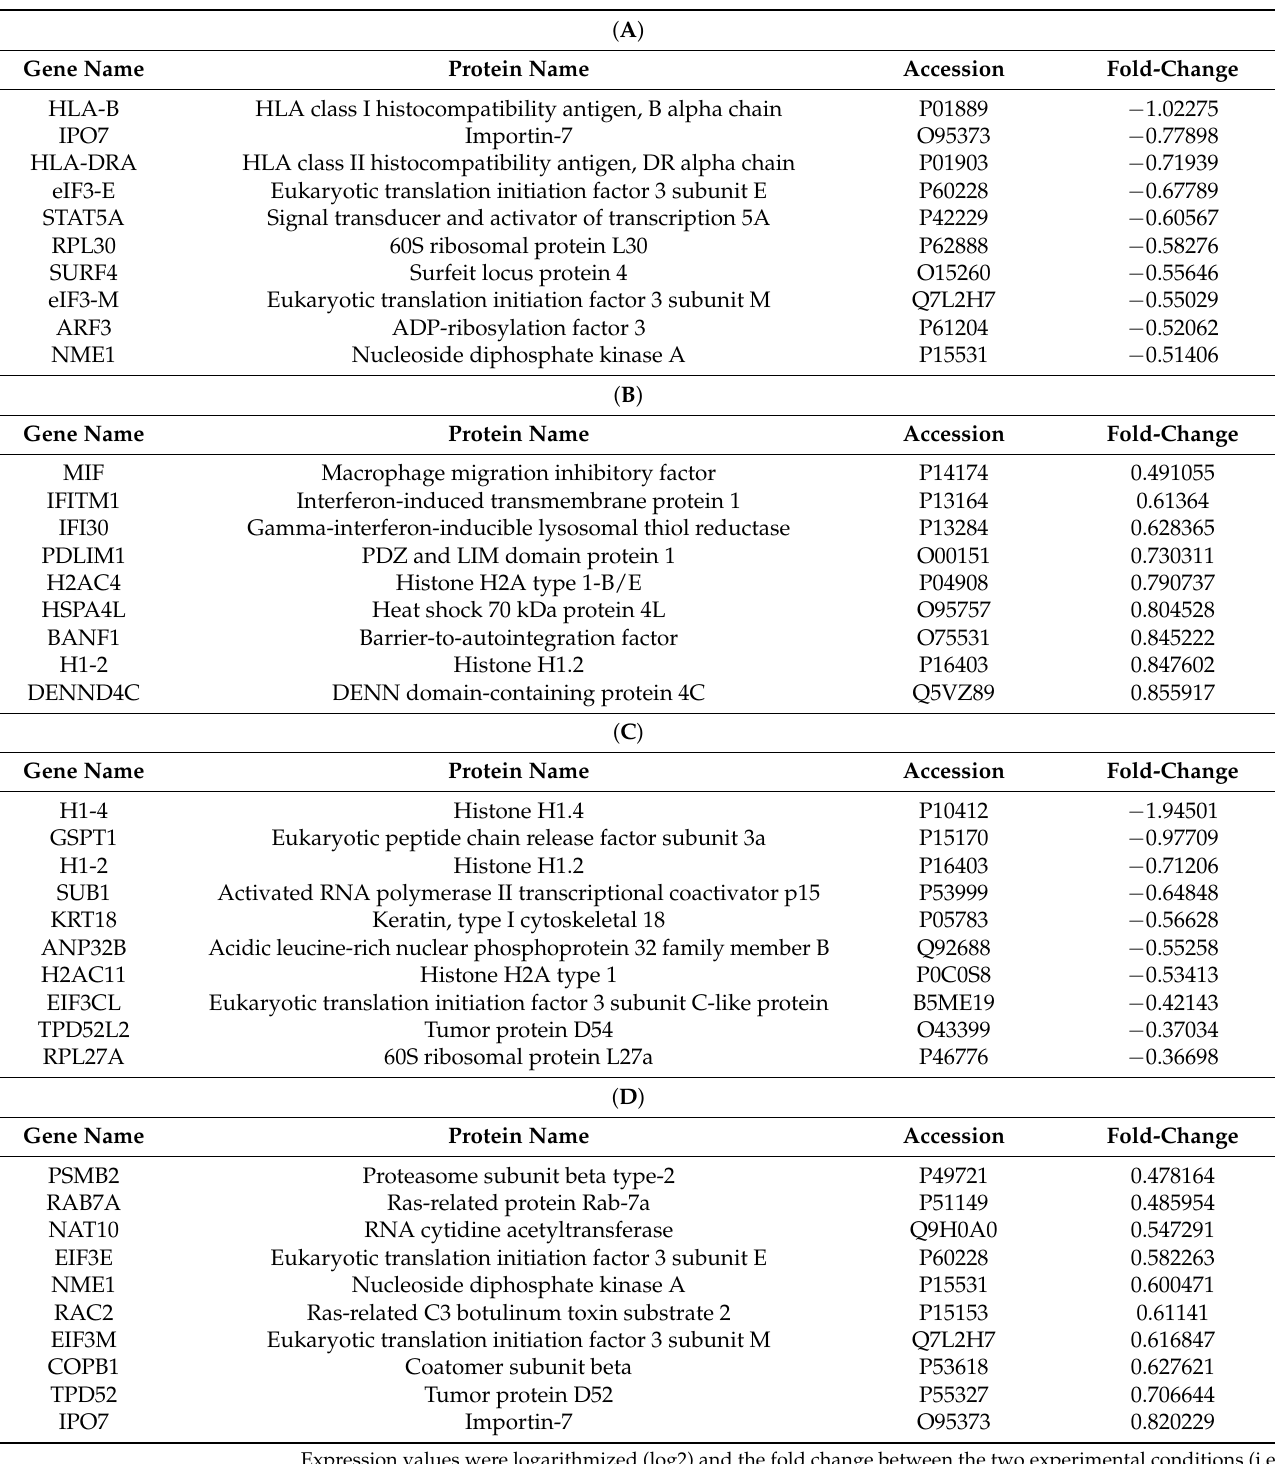
Table 1. The top 10 upregulated ( A , C ) and downregulated ( B , D ) proteins in Raji and Daudi cells after treatment with